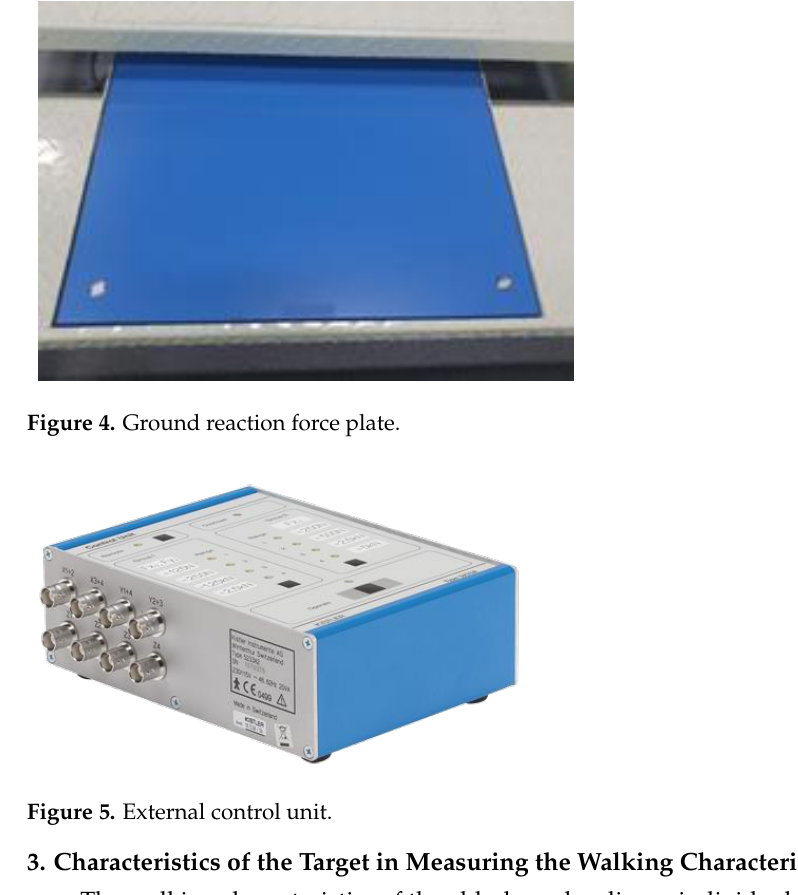
Figure 5. External control unit.